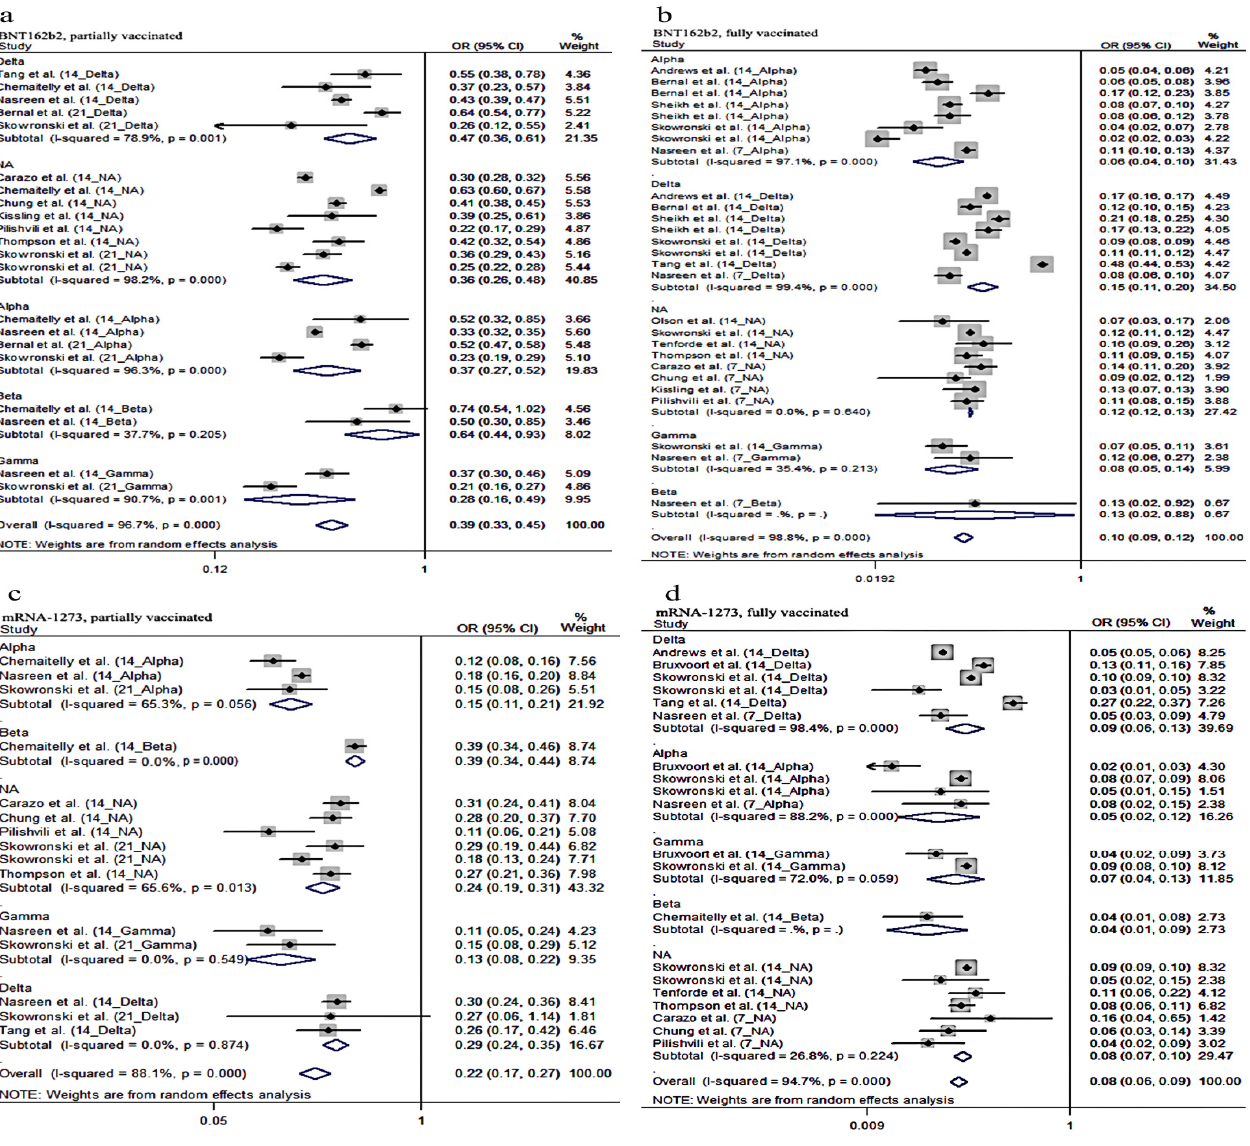
Figure 3. Forest plot odds ratio (OR) against VOC ( a ): OR with 95% confidence intervals (CI) against VOC (partially vaccinated BNT162b2); ( b ): OR with 95% confidence intervals (CI) against VOC (fully vaccinated BNT162b2); ( c ): OR with 95% confidence intervals (CI) against VOC (partially